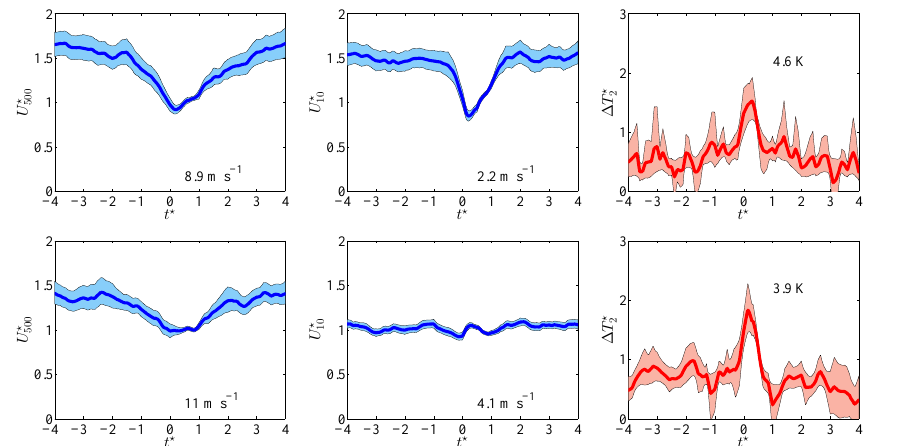
Figure 8. Composite of the time evolution of the wind speed at 500-hPa and 10-m levels and the 2-m air temperature anomaly for the whole Mediterranean region, based on the BA diagnostic for the HWM (upper row) and WFM (lower row) wildfires. The plotted values are normalized according to Eq. (1). Normalized time t ∗ = 0 and t ∗ = 1 correspond to the starting and ending dates of the wildfire activity, respectively. The value of (cid:107) U 500 (cid:107) , (cid:49)T 2 and (cid:107) U 10 (cid:107) are indicated in each sub-panel. Blue figures are plotted with their 99% confidence intervals and red figures with their 90% confidence